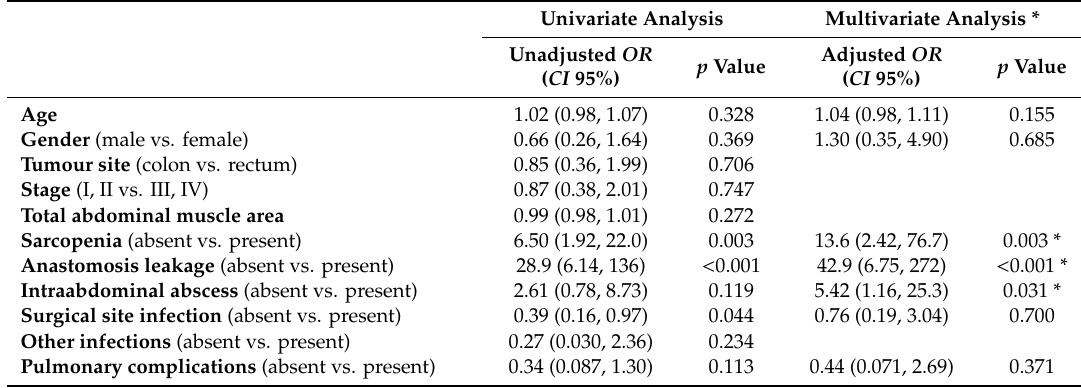
Table4. Univariateandmultivariatelogisticregressionanalysesofthepredictorsformajorpostoperative complications (Clavien–Dindo classification ≥ grade III).